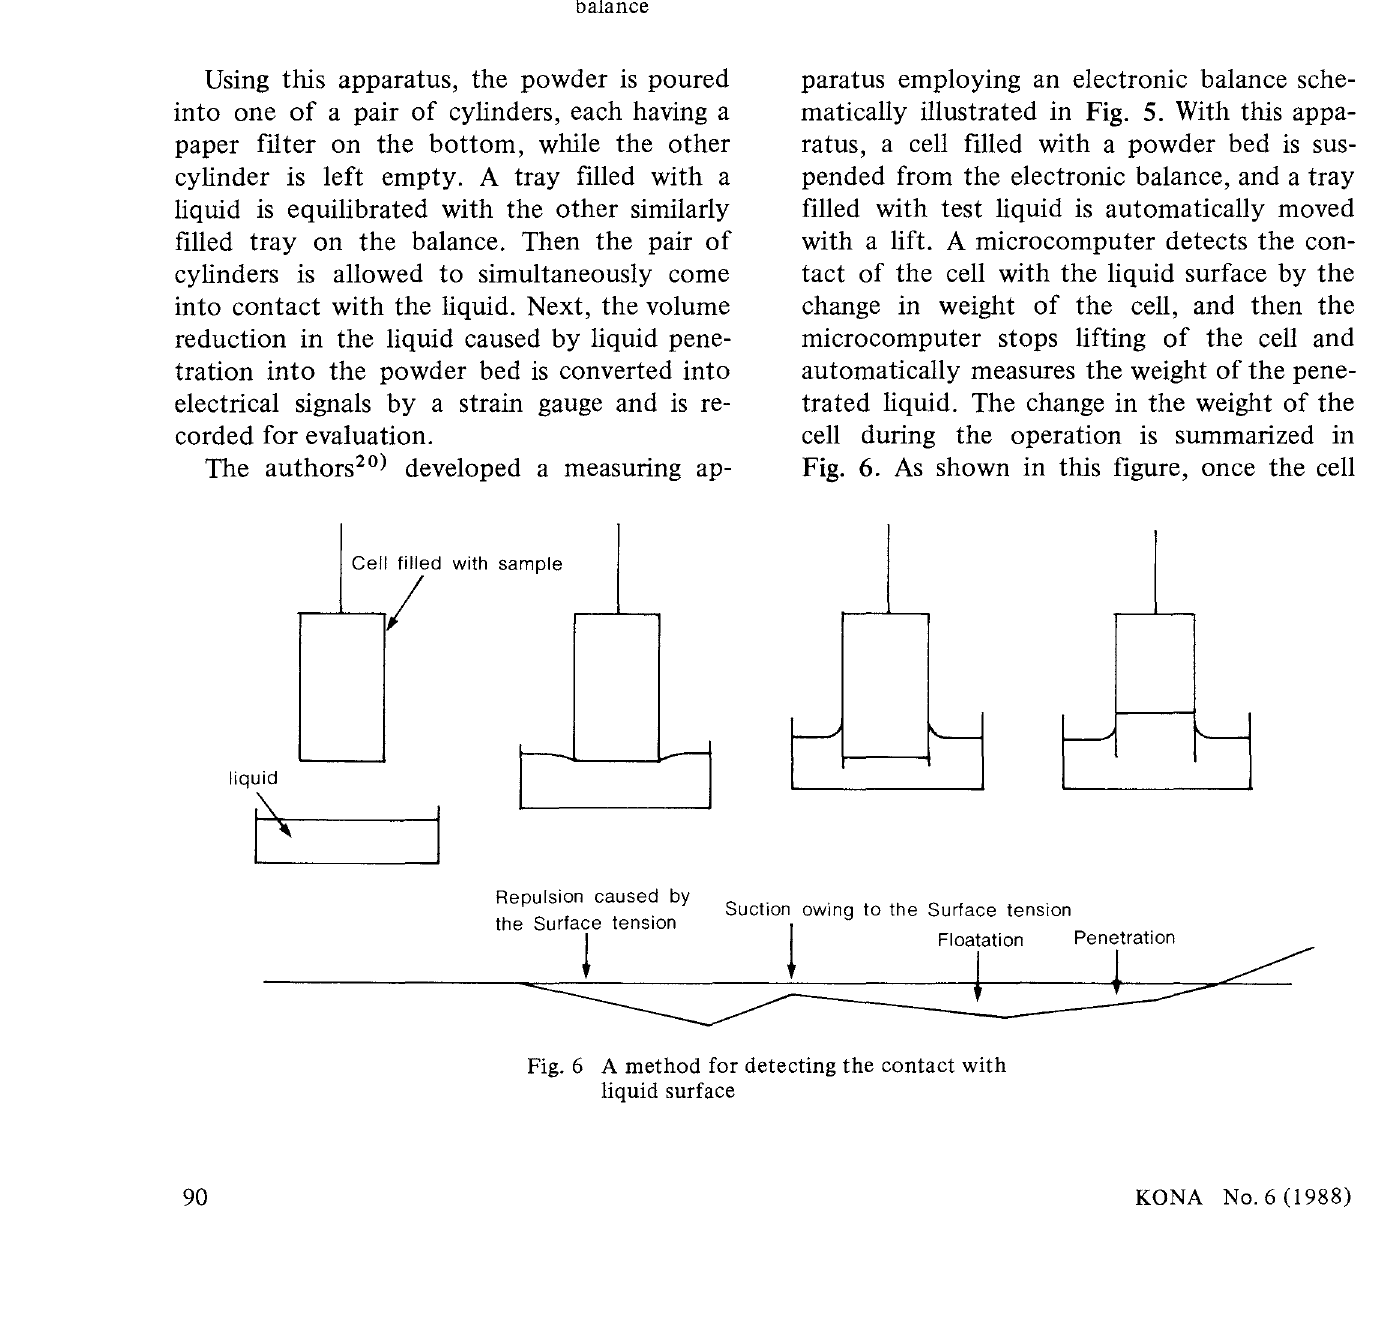
Fig. 5 A measurement apparatus based on electronic